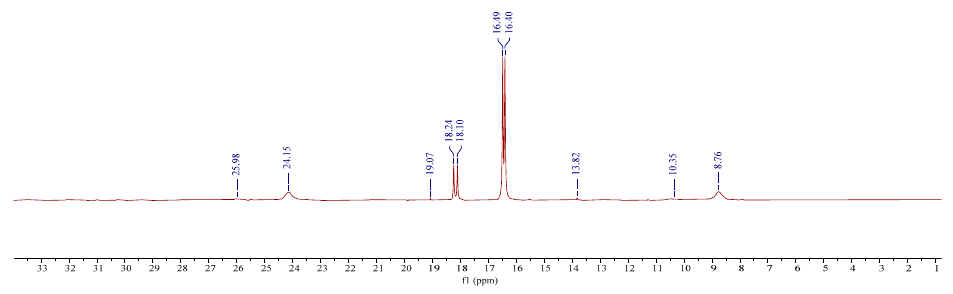
Figure 1. 1 H NMR spectrum of complex 5 in DMSO- d 6 at room temperature, after 6 days in solution.